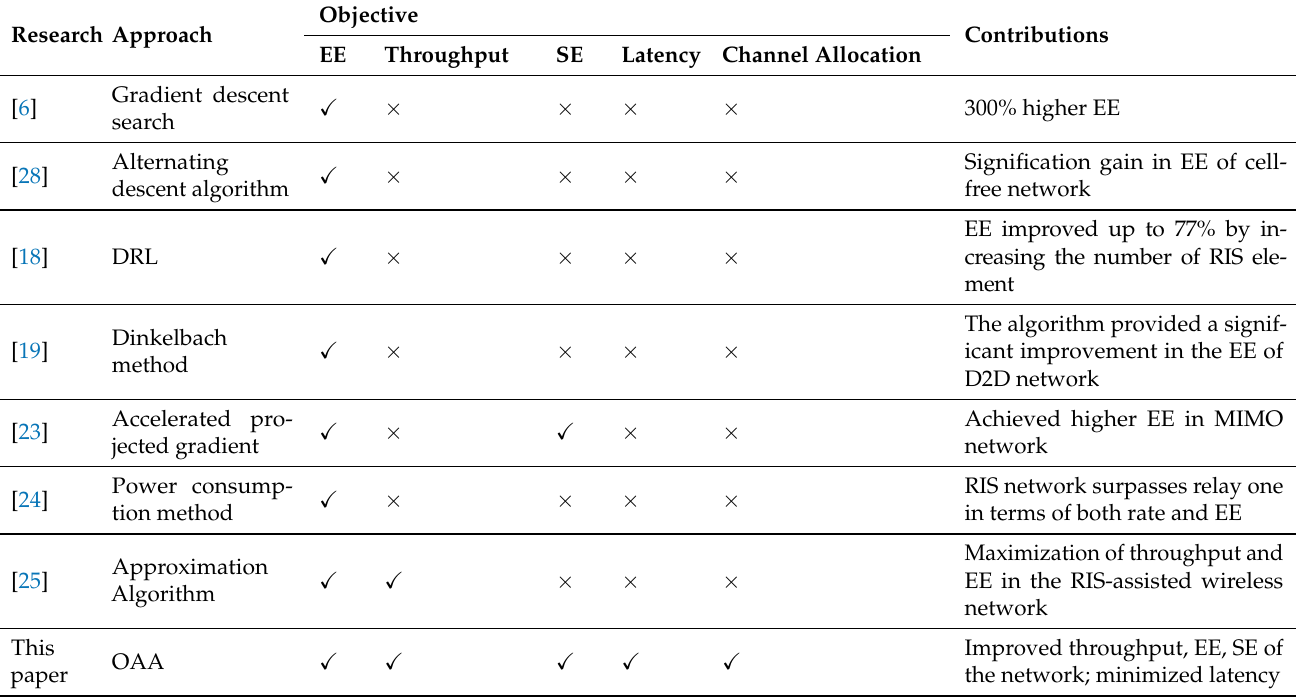
Table 1. Summary of Existing RIS-assisted Wireless